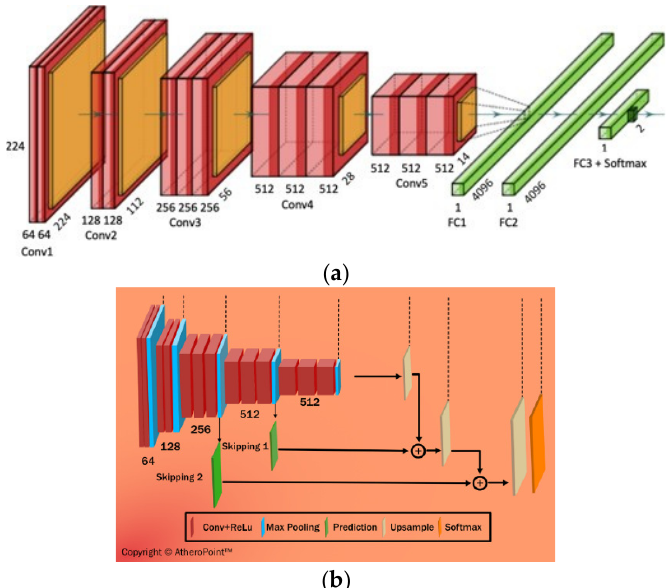
Figure 14. ( a ) DL ‐ CNN model for characterization, ( b ) DL ‐ FCN model for segmentation [44]. Figure 14. ( a ) DL-CNN model for characterization, ( b ) DL-FCN model for segmentation [44].